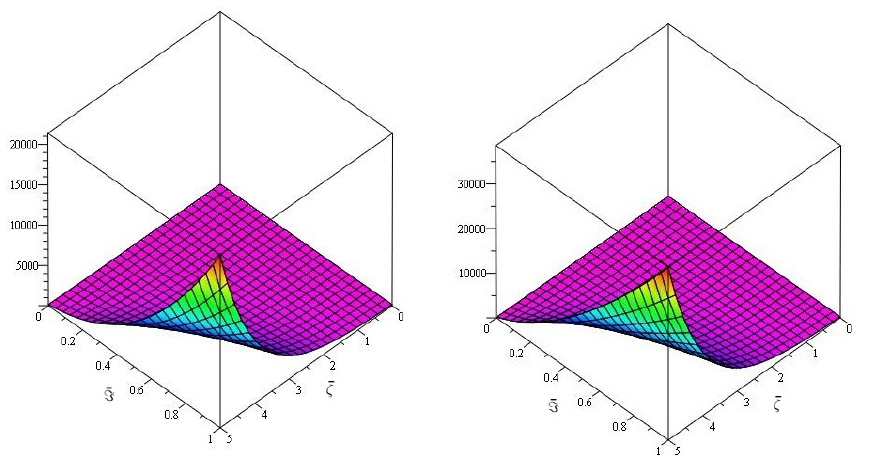
Figure 10. The first graph of analytical solution of β = 1 and second is β = 0.8 for Example 3.